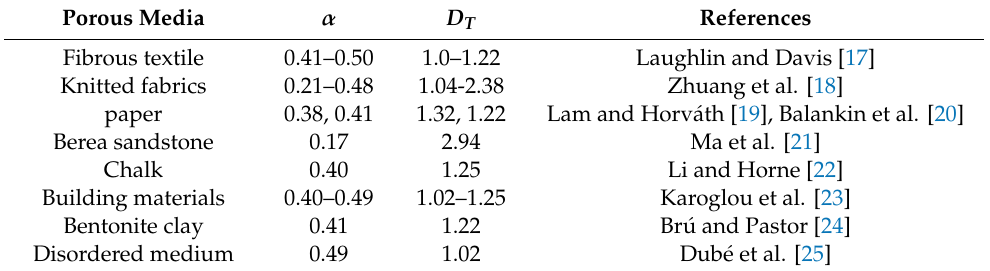
Table 3. Time exponent α and tortuosity fractal dimension D T from di ff erent imbibition